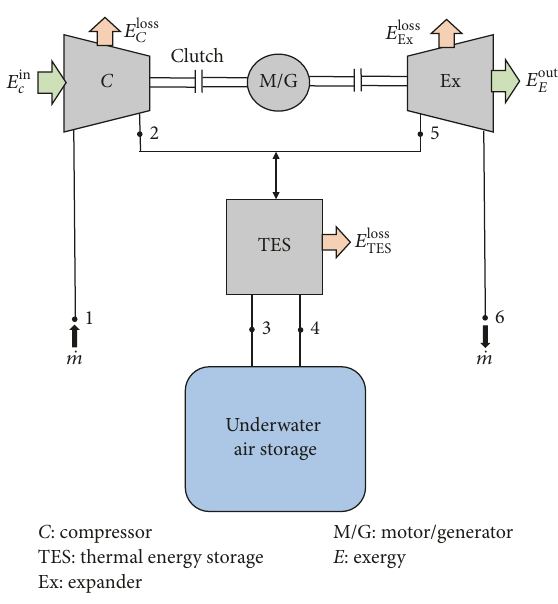
Figure 2: Schematic of adiabatic